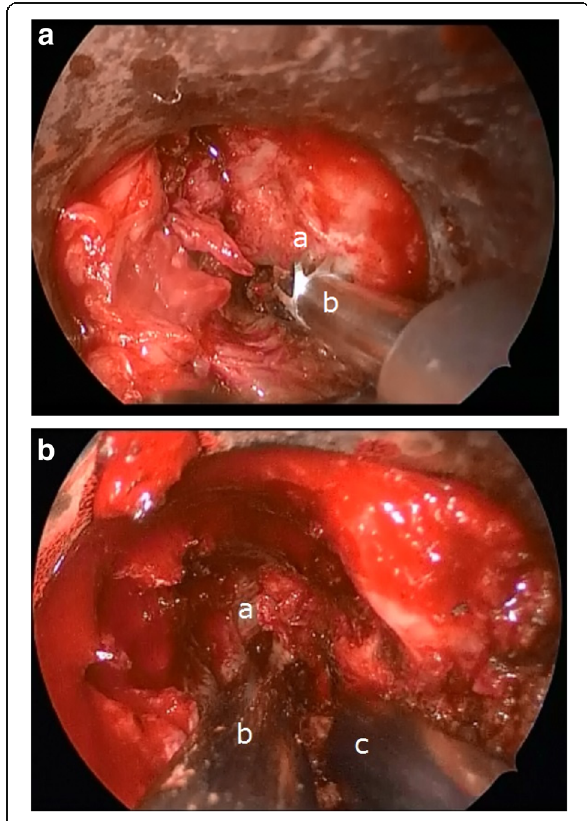
Fig. 2 a Intraoperative endoscopic view during the start of a left sided FLLDH excision. (a) Lateral edge of lamina. (b) Micro-drill burr at start point of drilling. b Endoscopic view at the end of operation for the same patient showing (a) lower aspect of exiting nerve root, (b) suction device in place after disc fragment removal, and (c) micro-dissector